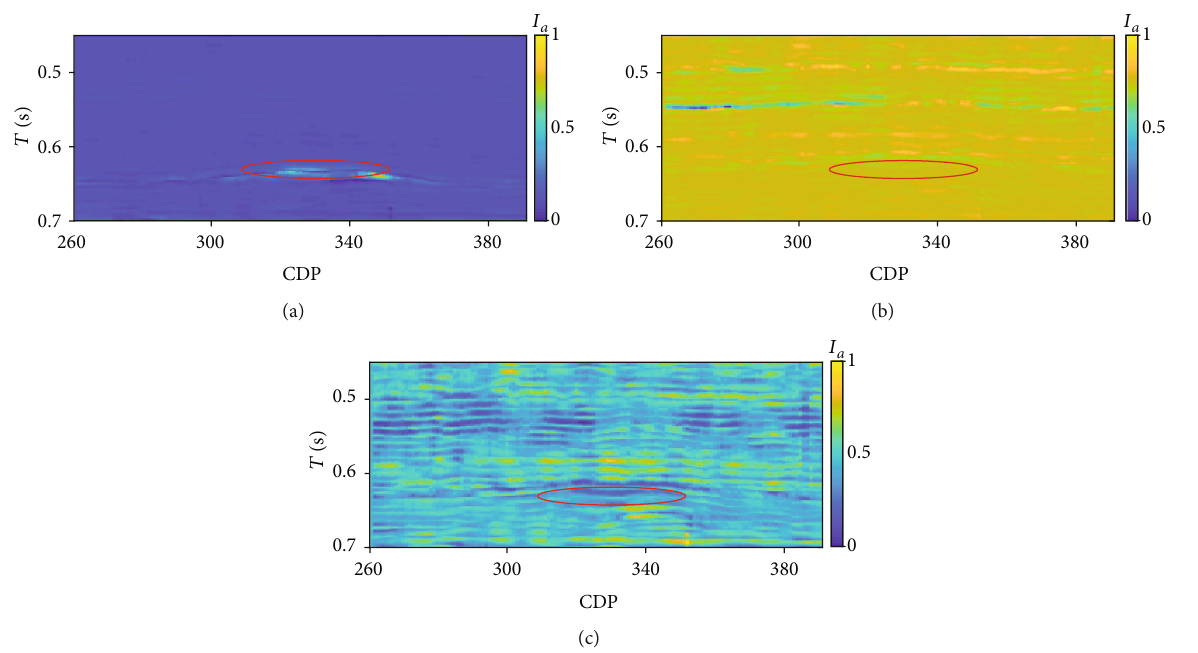
Figure 9: Analysis of dispersion terms of Russell fl uid factor with di ff erent γ 2 corresponds to the dispersion term with γ 2 dry = 8 : 9 ; (c) corresponds to the dispersion term with γ 2 dry = 15 ; the red circle highlights the location of the gas reservoir.